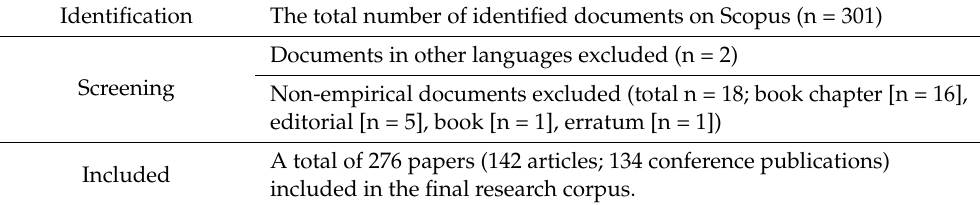
Table 2. The PRISMA